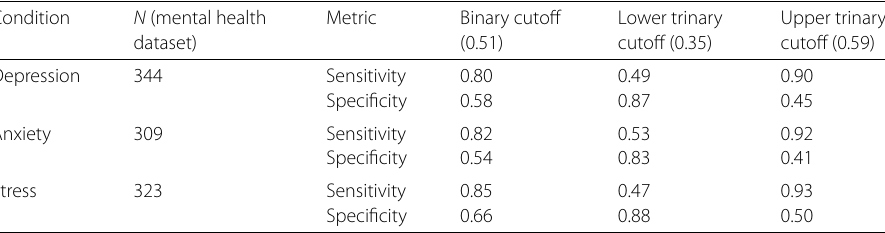
Table 1 Specificity and sensitivity of the selected WHO-5 cutoff values in the mental health dataset Condition N (mental health dataset) Depression 344